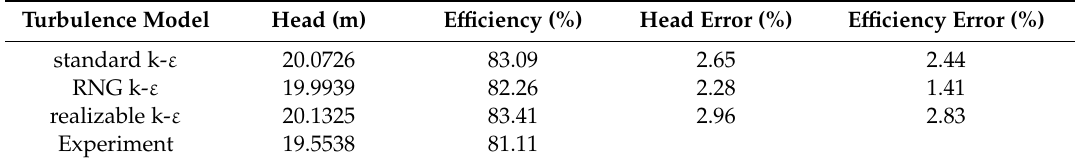
Table 2. Selection of turbulence model.